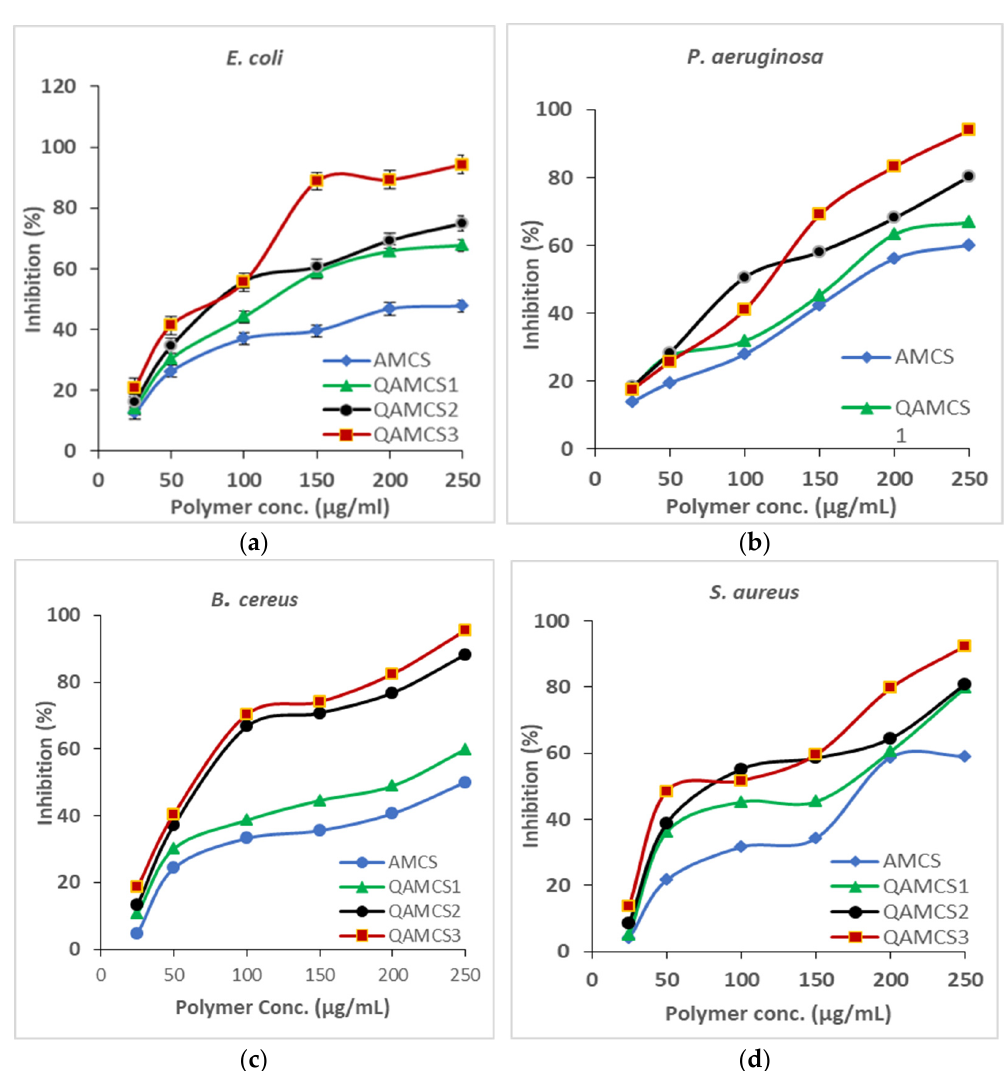
Figure 7. MIC results of different concentrations of aminochitosan, quaternized aminochitosan 1, quaternized aminochitosan 2 and quaternized aminochitosan 3 membranes against ( a ) E. coli , ( b ) P. aeruginosa , ( c ) B. cereus and ( d ) S. aureus . All measure- ments were accomplished in triplicate ( n = 3), and data obtained are expressed as means and standard deviations. ( ±